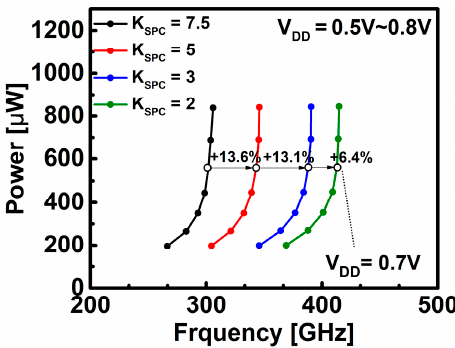
Figure 6. Power versus frequency for DG WS 2 -FET according to K SPC .